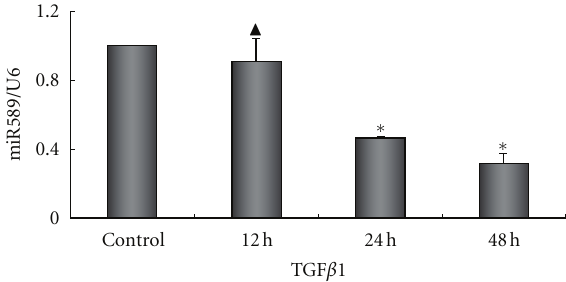
Figure 2: Expression of miRNA589 in HMrSV5 cells following exposure toTGF β 1 (5ng/ml, 0–48 hr), as assessed by realtime PCR. The bar graphs show the 2 − ΔΔ C T value of miRNA589 relative to that of U6 in HMrSV5 cells following exposure to TGF β 1 (5ng/ml, 0–48 hr). Expression of miRNA589 decreased in a time-dependent manner in HMrSV5 cells treated with TGF β 1 (column 2, 3, 4). The 2 − ΔΔ C T of miRNA589 expression level of HPMCs treated with TGF- β 1 for 24h and 48h were 0.4610 ± 0.01608 ( P < 0.05) and 0.3187 ± 0.06036 ( P < 0.05) as the mean ratio ± SD, respectively. Δ P > 0.05 versus control group, ∗ P < 0.05 versus control group.